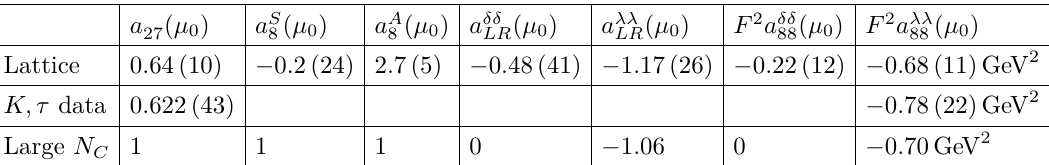
Table 5 . Values at µ 0 = 1 GeV ( MS -NDR) of the a i ( µ 0 ) parameters, extracted from a NLO fit to the lattice data (first line) and from experimental data (second line), compared with their large- N C predictions (third